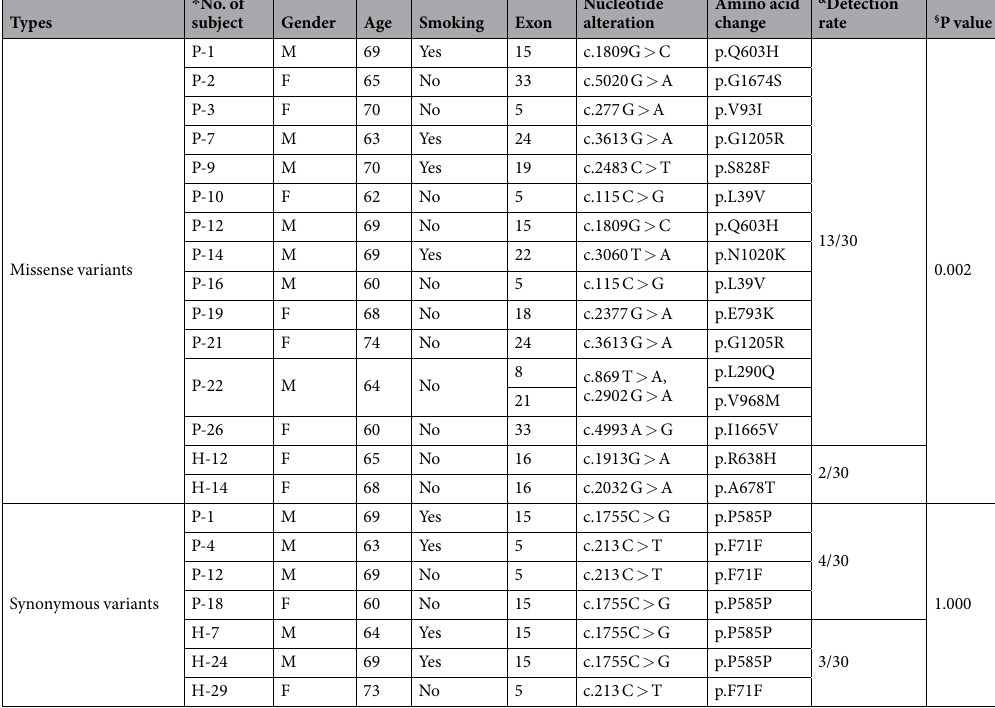
Table 2. The variants detected in ABCA3 gene by sequencing in 30 sporadic IPF patients and 30 healthy controls. * P: Patient number; H: Healthy control number; & Number of carriers detected in 30 IPF patients or 30 healthy controls; § A comparison between the rates of variant carriers in 30 IPF patients and 30 healthy controls (Fisher’s exact test).